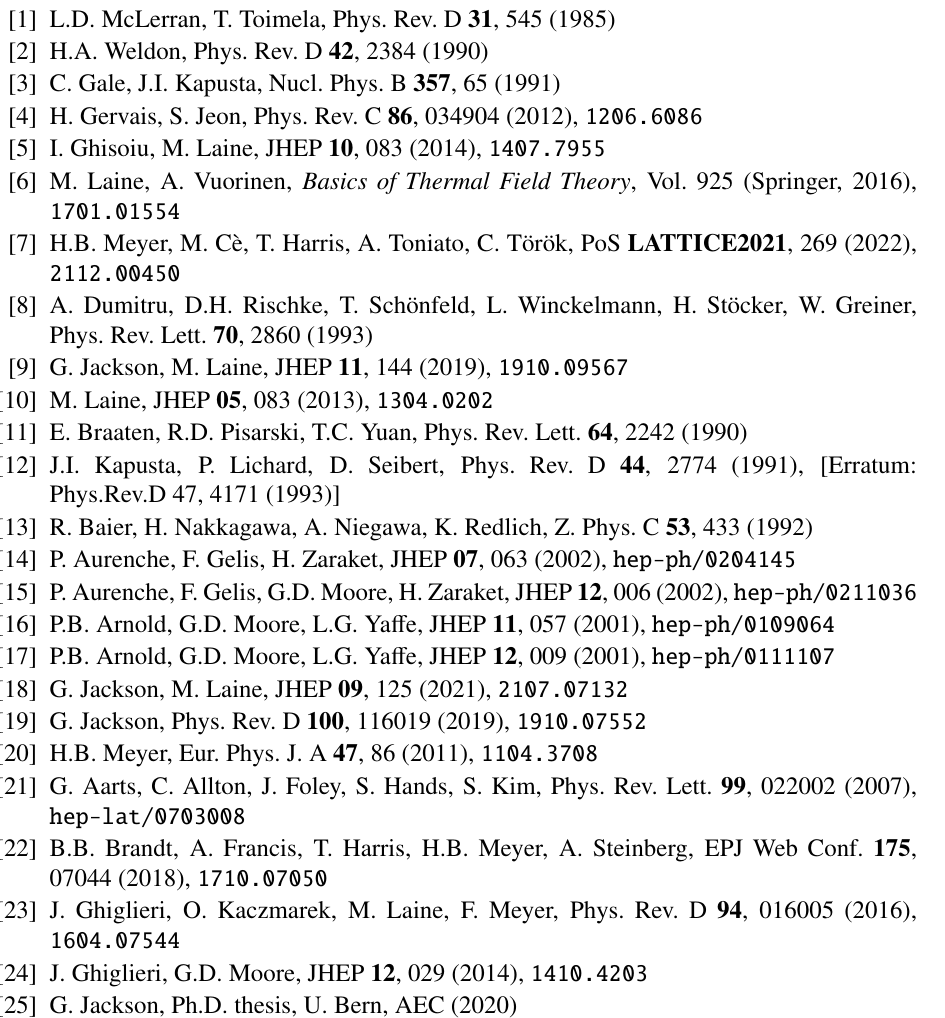
fig. 2. I am also grateful to T. Gorda, K. Seppänen and R. Paatelainen for their